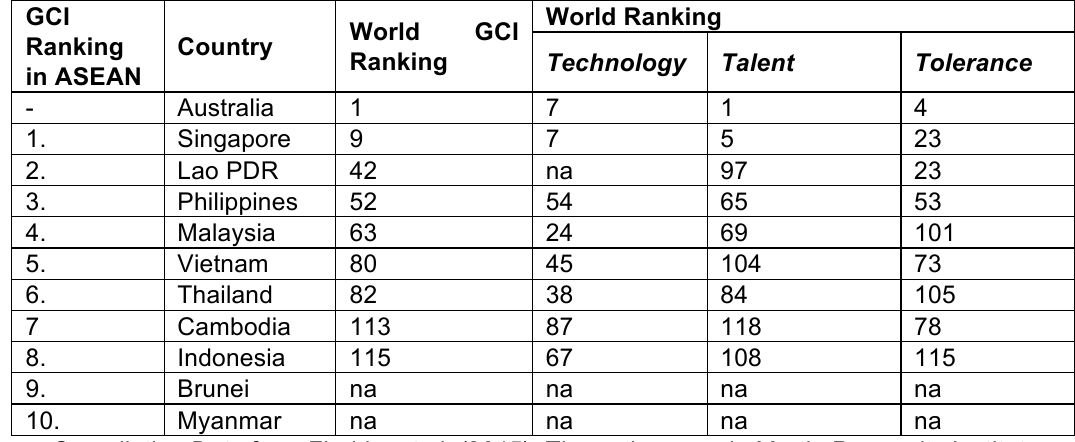
Table 4: Relevant Global Creativity Index /GCI Ranking (2015)